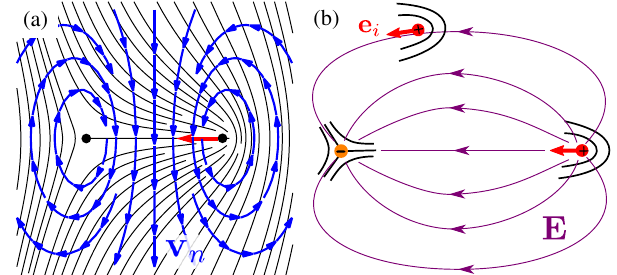
FIG. 7. (a) The elastic distortion created by a neutral pair of (cid:1) 1 = 2 defects at a finite separation. The director is marked in black, and the phase gradient v n is in blue. (b) A schematic with the neutral defect pair in the same configuration as in (a). The analog electric field E ¼ ϵ · v n shown in purple lines traces out the familiar electric field lines between a pair of opposite-sign electric charges. For extensile activity ( v < 0 ), a test þ 1 = 2 disclination shown above the neutral pair aligns its polarization e i with the electric field generated by the defect pair. This configuration shown here is the same as shown in Fig. 4, but now reinterpreted in terms of the analog electric field E . The contractile case works similarly, with some of the signs